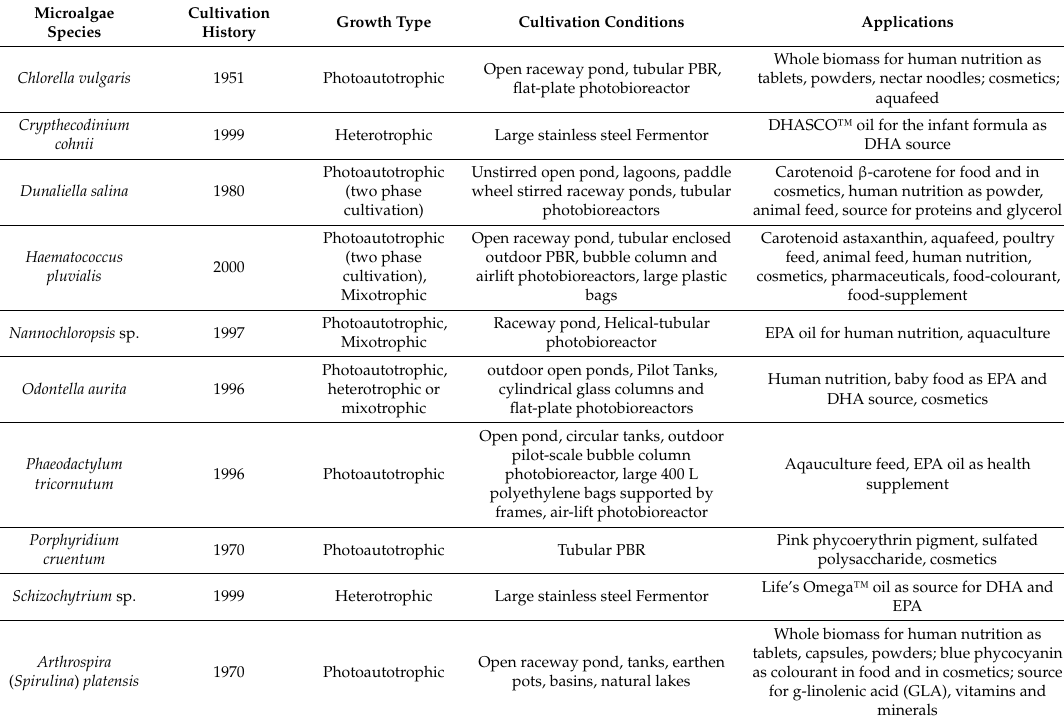
Table 1. Most popular microalgae and their mode of cultivation for various